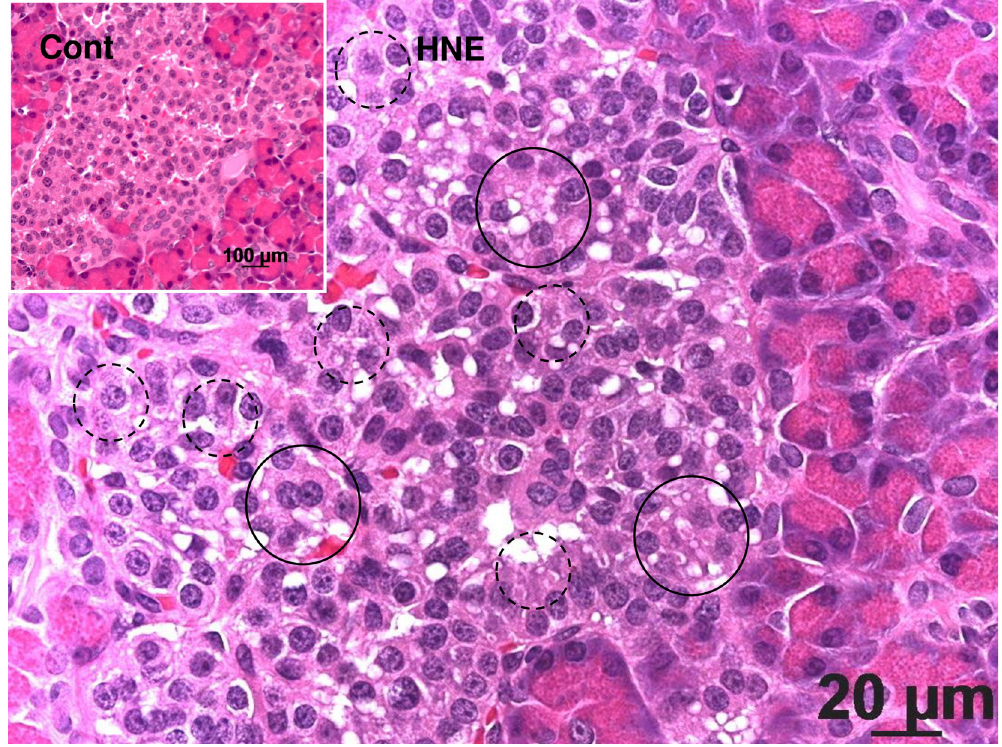
Fig 1. Light micrograph of the monkey pancreas. The Langerhans islet after the hydroxynonenal injections (HNE) shows many vacuole formation (circles), compared to the sham-operated control (Cont). Nuclear chromatin is generally more dense after the hydroxynonenal injections, compared to the control. A small number of nucleus shows diffuse dissolution or punctuate condensation (dot circle). However, neither apoptotic bodies nor membrane blebbings were seen. Acinar cells are distributed in the surrounding area. Hematoxylin-eosin